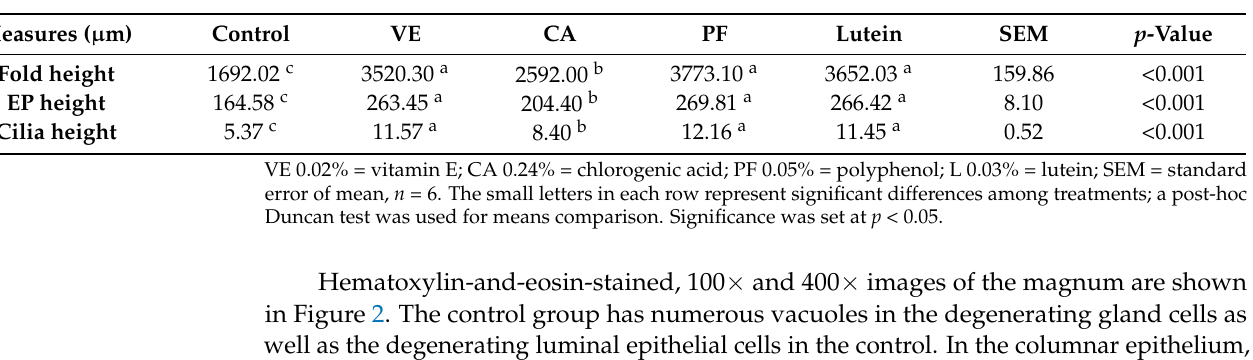
Table 8. The effect of different antioxidants on the magnum morphology of laying hens.